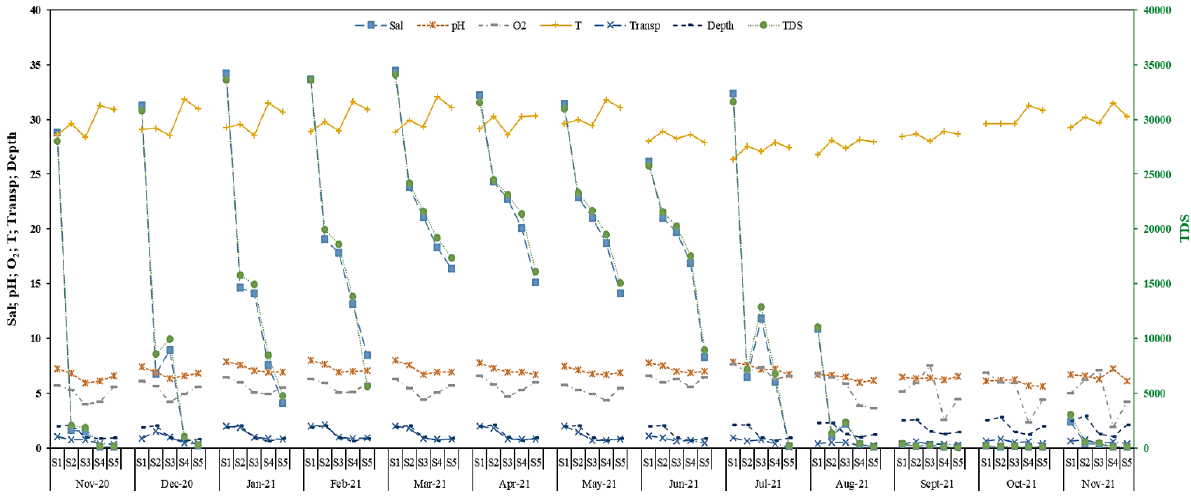
Figure 4. Rainfall in the south of Benin (http://www.meteobenin.bj (accessed on 1 June 2022)).